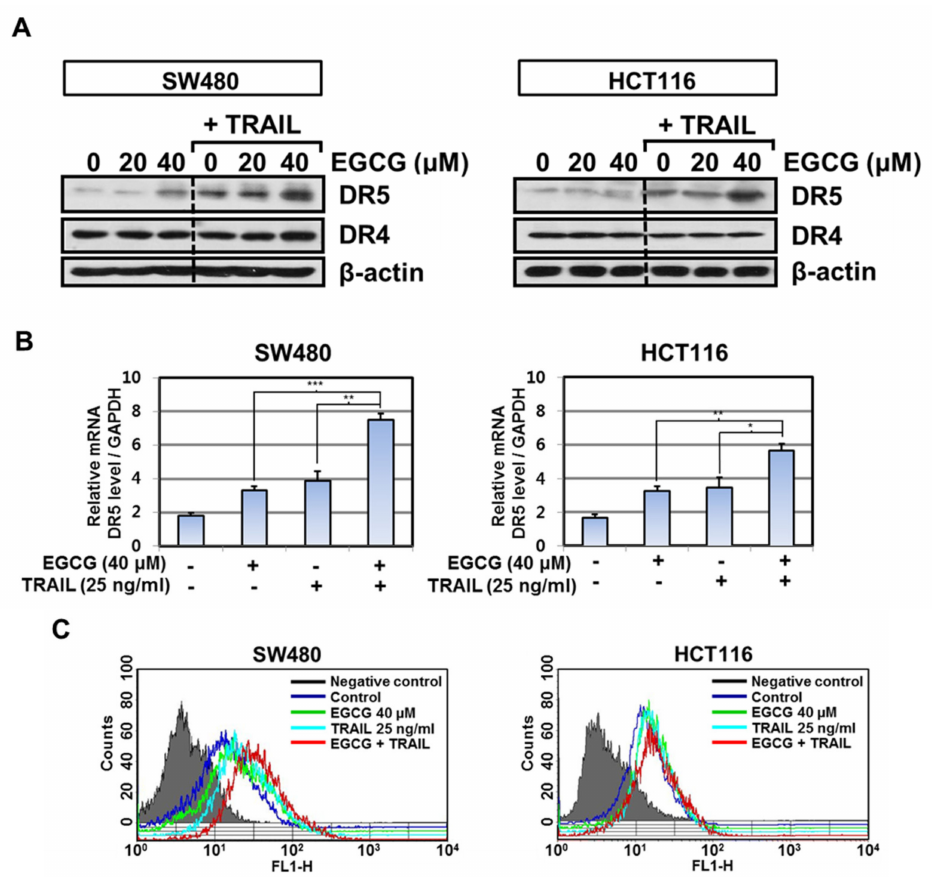
Figure 3. E ff ect of EGCG and TRAIL cotreatment on the expression of death receptor 5 (DR5) in SW480 and HCT116 cells. ( A ) SW480 and HCT116 cells were treated with TRAIL (25 ng / mL) and / or EGCG (20, 40 µ M) for 24 h. Cell extracts were prepared and subjected to Western blotting with death receptor 4 (DR4) and DR5 antibodies. β -actin was used as an internal control. ( B ) SW480 or HCT116 cells were treated with 40 µ M EGCG and 25 ng / mL TRAIL. Total RNA was isolated from the treated cells, and expression of DR5 at mRNA level was determined by RT-qPCR. The data were analyzed by two-way analysis of variance. * p < 0.05, ** p < 0.01, ***p < 0.001 vs. co-treated EGCG 40 µ M and TRAIL 25 ng / mL. ( C ) SW480 and HCT116 cells were treated with 40 µ M EGCG and / or TRAIL 25 ng / mL for 24 h. Cells were then stained with FITC-conjugated antibodies for DR5 or IgG control (negative control), and expression of DR5 on the cell surface was analyzed using flow